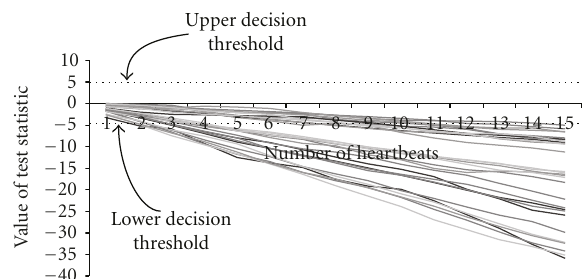
Figure 9: Sequential test statistics for all subjects when H 0 is true. The test data are from the declared individual.